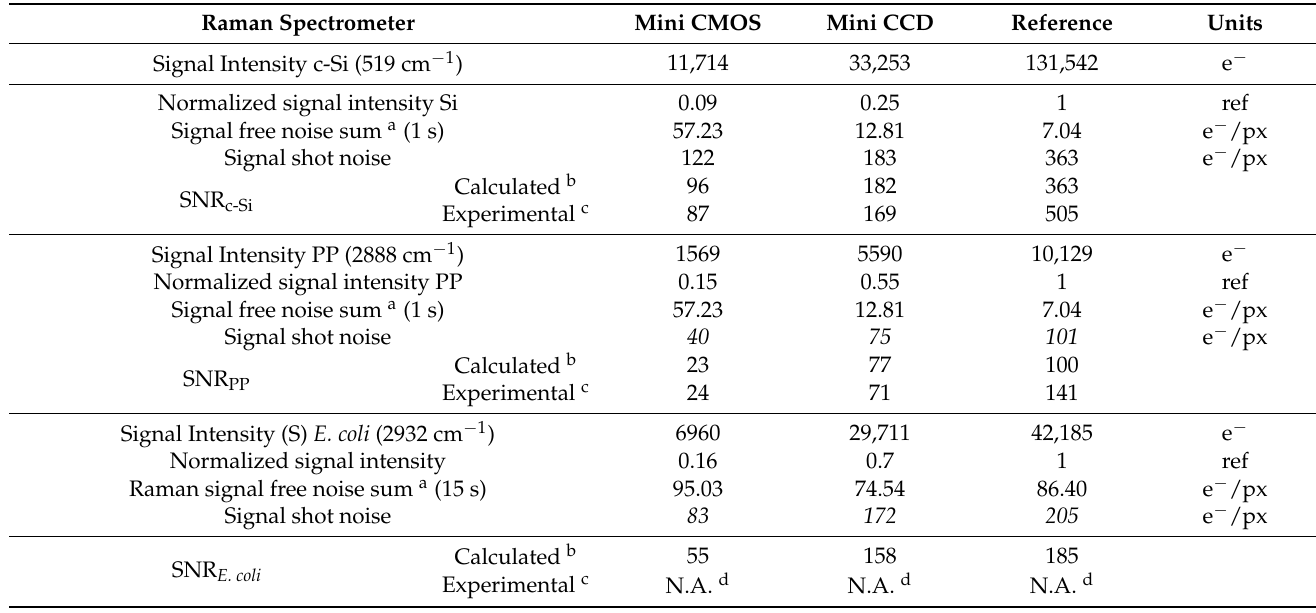
Table 2. Calculation of SNR for c-Si, PP and E. coli bacteria related to a single spectral class. For further information see Section S5, Tables S3 and S4 of the Supplementary